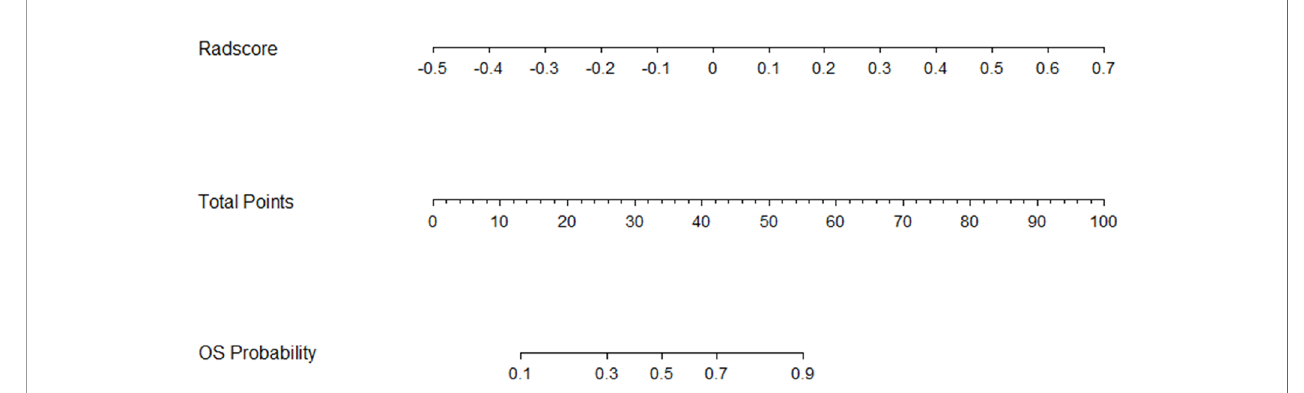
FIGURE 4 | The radiomics nomogram for OS strati fi cation of GBM patients.